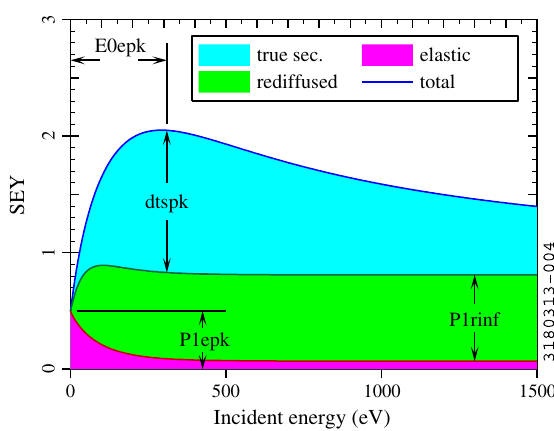
FIG. 3. Secondary electron yield as a function of energy, with important POSINST parameters